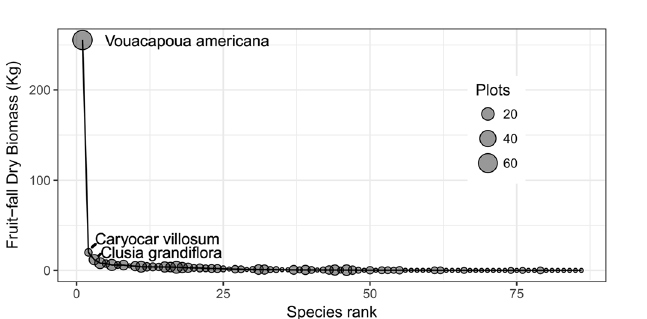
Figure 1. Location of the study site in Amapá National Forest (ANF), Amapá State, north-eastern Brazilian Amazon. ( A ) State of Amapá in Brazil. ( B ) Location of ANF in Amapá. ( C ) Elevation (10-m) across the grid system (white dotted lines); permanent and trail sampling plots (black and pink solid lines respectively) where fruit-fall ground surveys were conducted from May to June 2016. This figure was generated using ArcGIS version 10.8 (https ://deskt op.arcgi s.com/en/arcma p/). Country boundaries and basemaps were obtained from Natural Earth (https ://www.natur alear thdat a.com/).